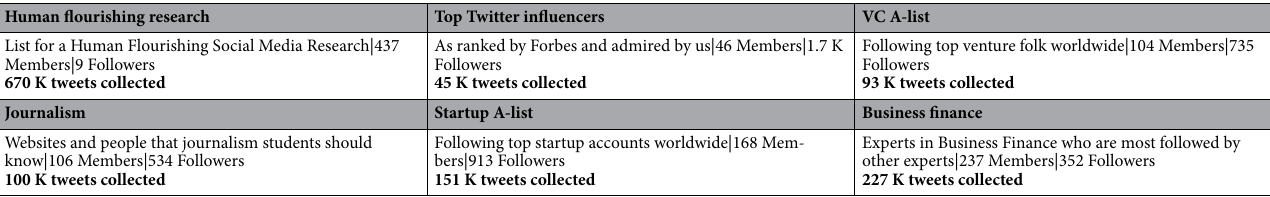
Table 1. Summary of the data collected from the HF Twitter list as well as other five lists for